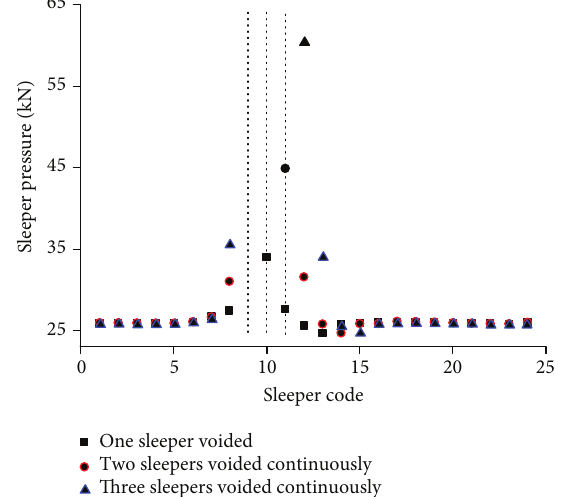
Figure 14: Effect of continuous voided sleepers on the sleeper